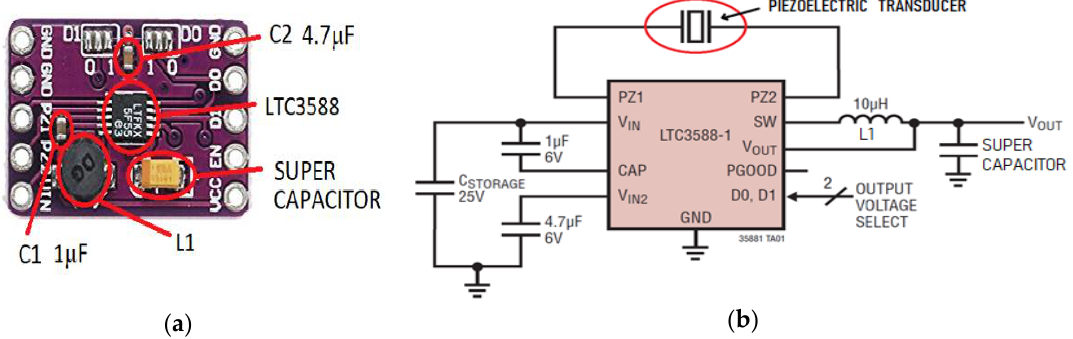
Figure 8. Top view ( a ) and schematic ( b ) of the conditioning board based on LTC3588-2 IC, used to harvest energy from piezoelectric transducers.